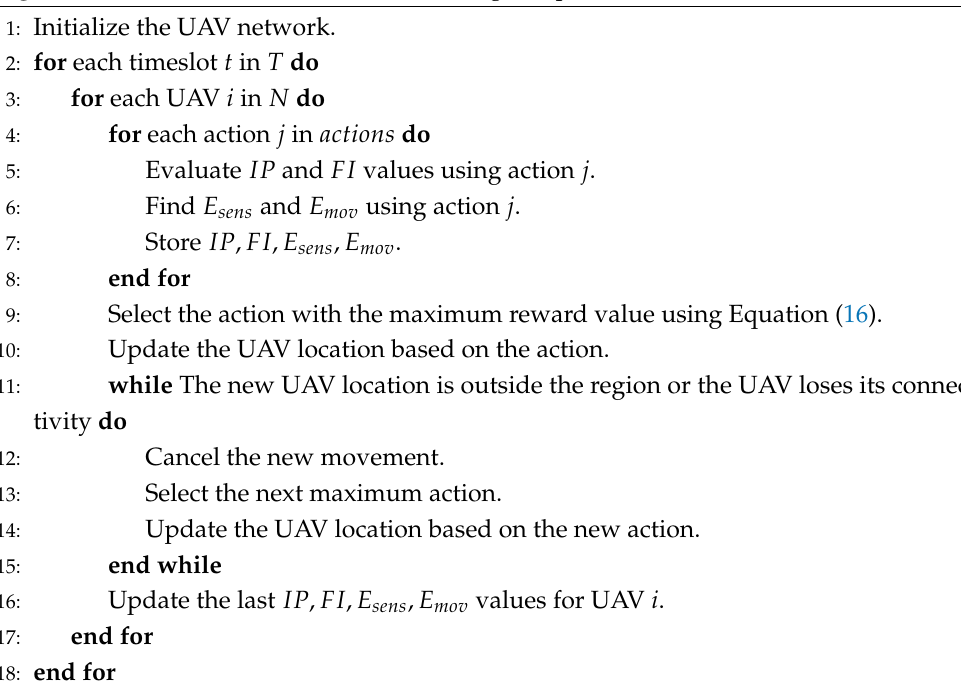
Algorithm 1. Pseudocode for the state-based game